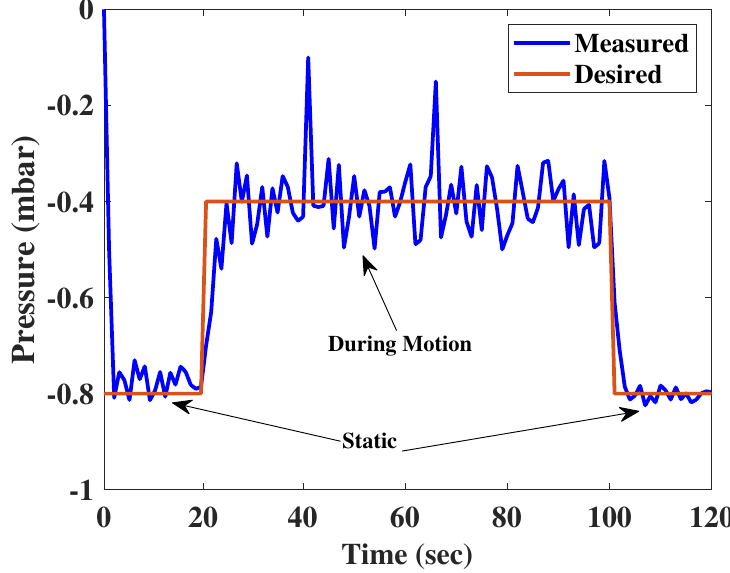
Figure 21. Closed loop performance of the